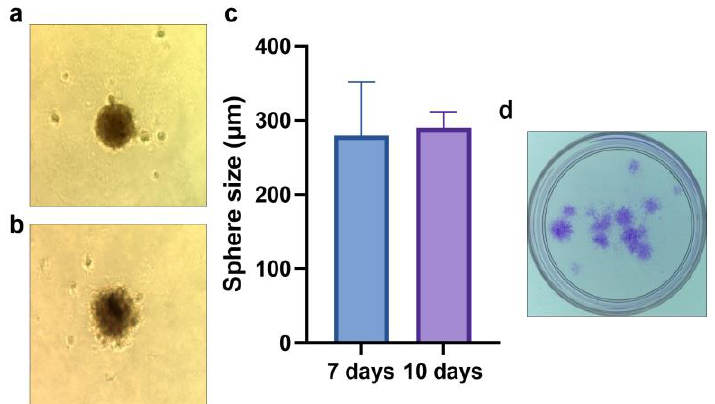
Figure 2. CSC properties of the isolated CD44 + cells–spheroid formation after 7 ( a , c ) and 10 days ( b , c ); colony forming assay after 7 days ( d ). Sphere microphotographs are at 40 × magnification.